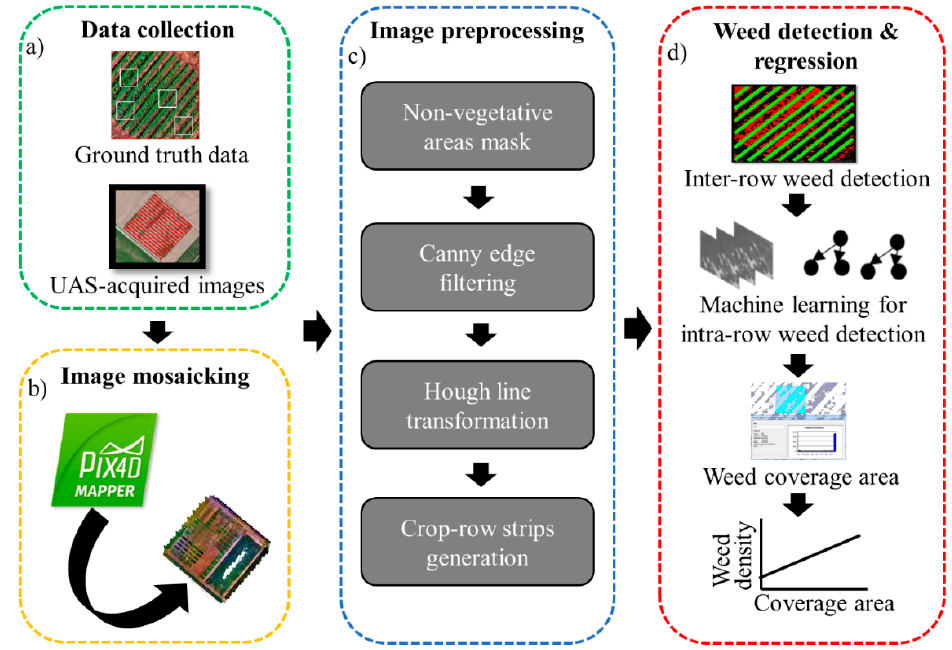
Figure 2. Flowchart for the overall methodology followed in this research for mapping weeds in a cotton field. The specific steps included (shown in dashed boxes) are: ( a ) data collection, ( b ) image mosaicking, ( c ) image preprocessing, and ( d ) weed detection and regression.